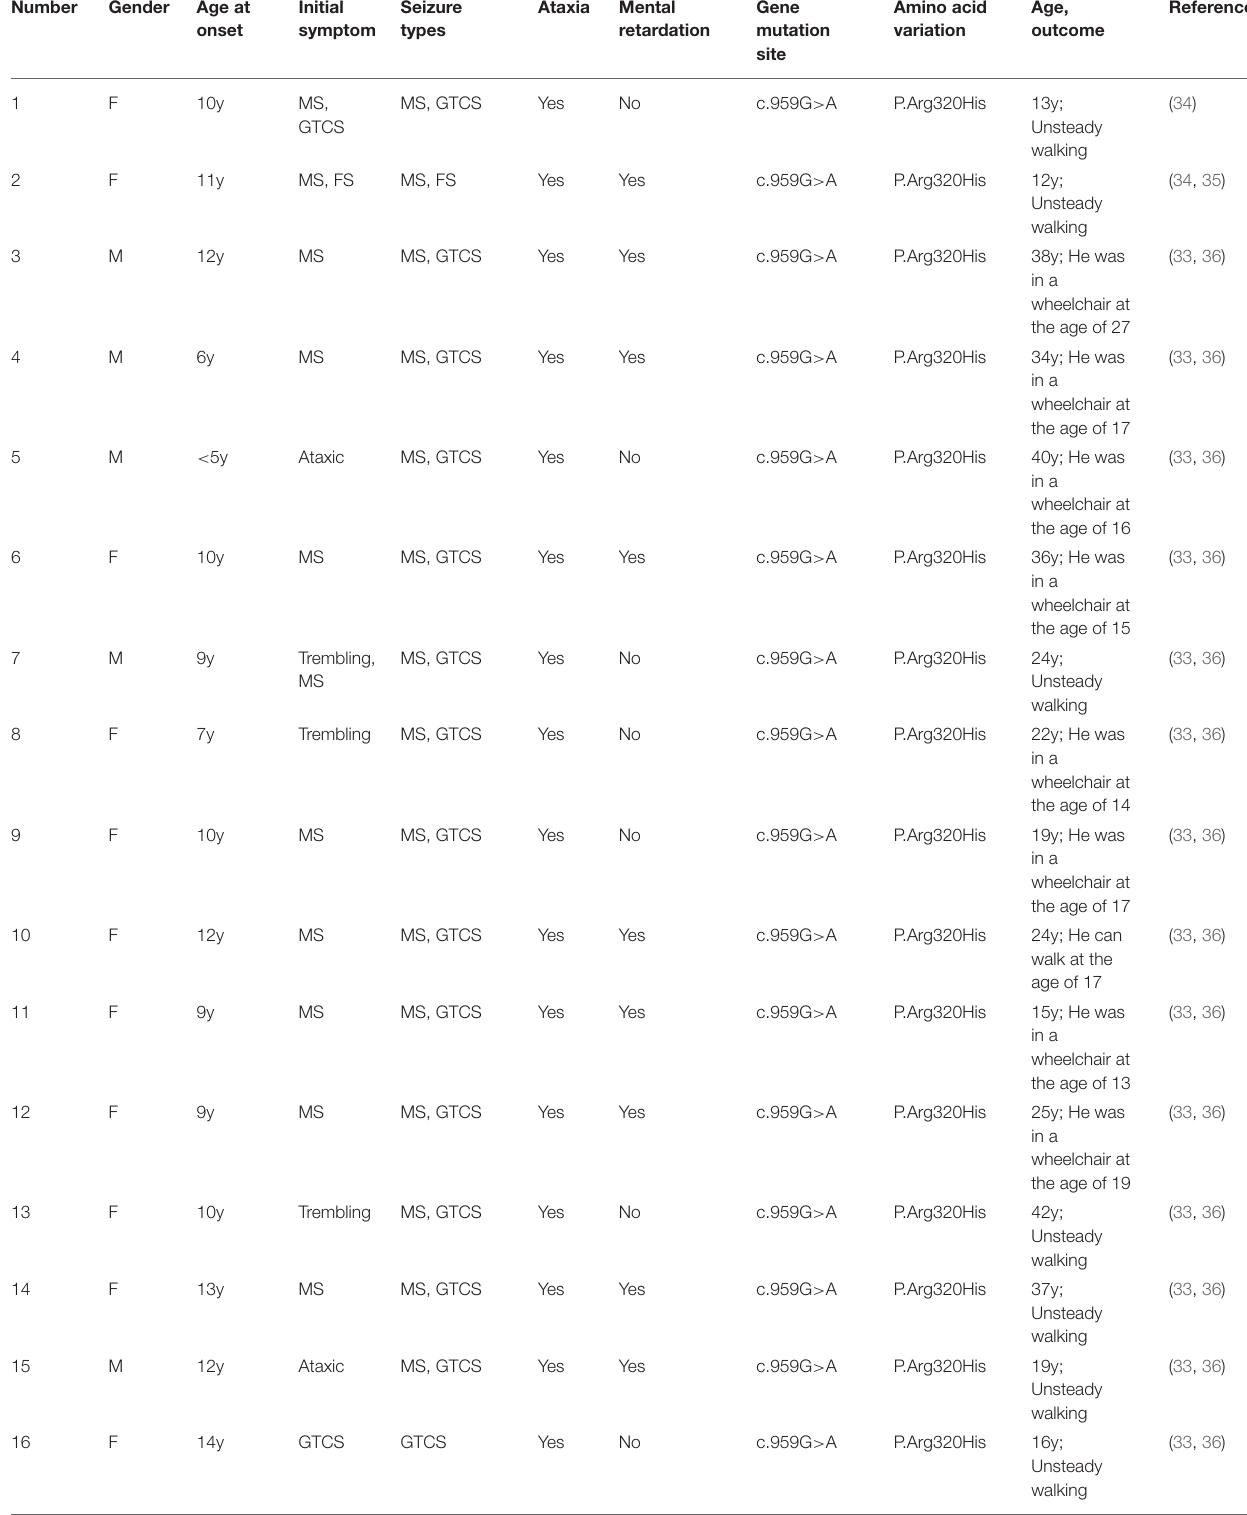
TABLE 3 | The clinical features and gene test result of 24 patients with mutation site of c.959G > A. Number